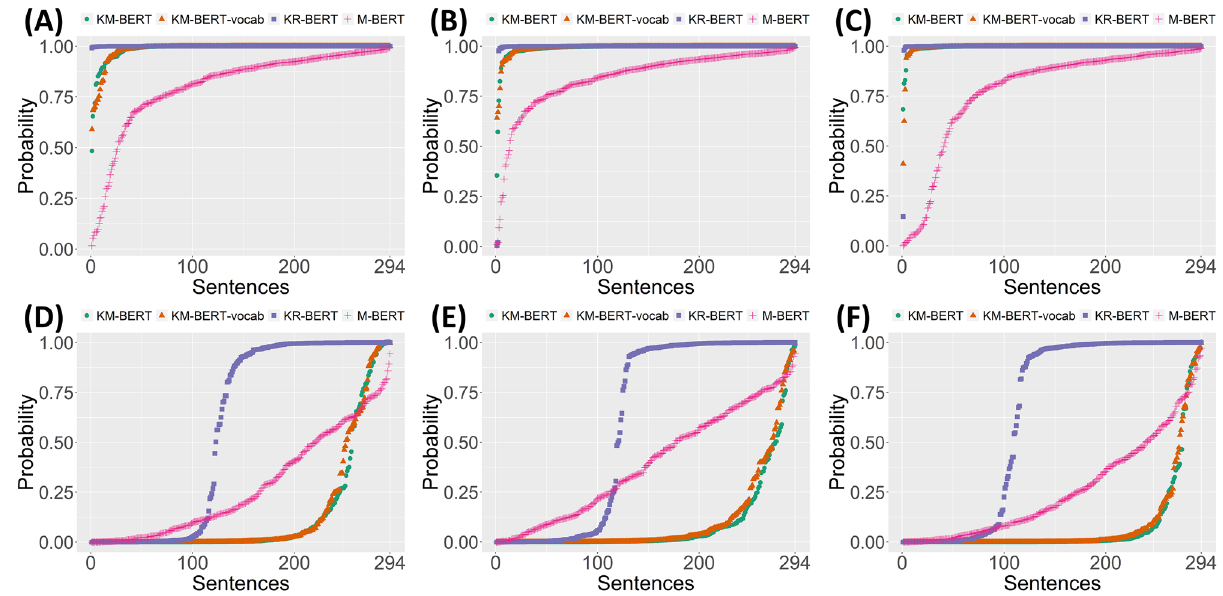
Figure 4. Distribution of the predicted next sentence probability for the NSP task. ( A – C ) Medical textbook, health information news, and medical research article with the next sentence relationship. ( D – F ) Random sentence pairs for corpus types that correspond to ( A – C ) with no next sentence